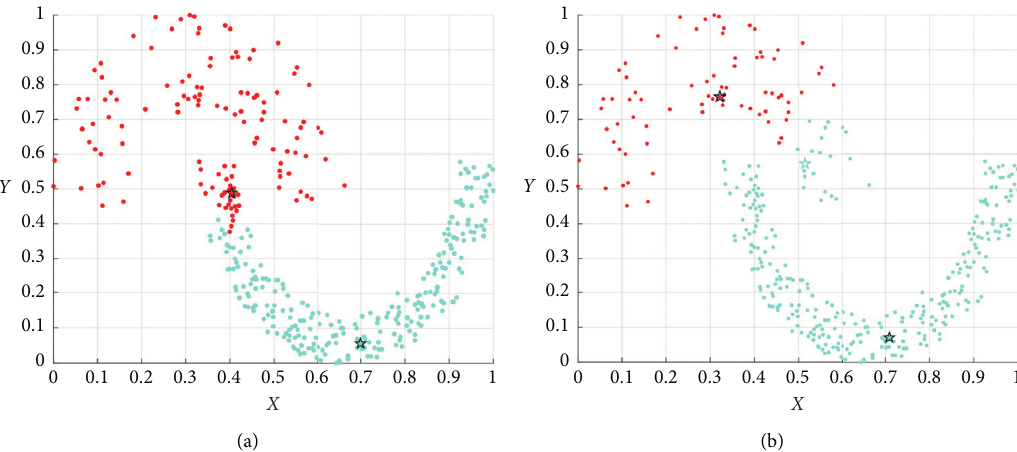
Figure 1: Clustering results of DPC on the Jain dataset. The diverse colors present different clusters, and the stars mark the cluster centers and prominent local peaks. (a) Clustering results of DPC on Jain. (b) Clustering results of DPC with modified center.